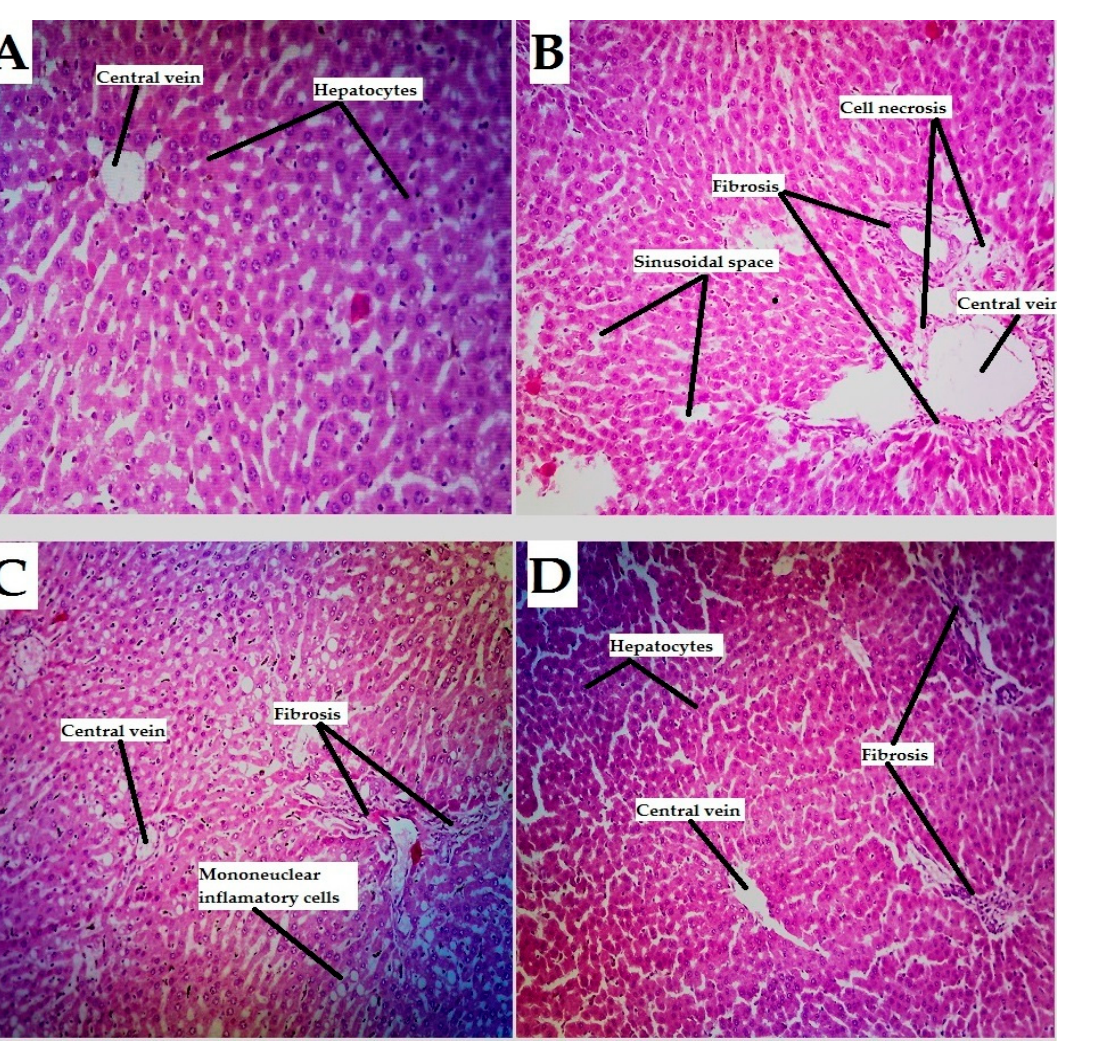
Figure 2. Histological section of rat’s liver. ( A ) The normal group showing the regular histological structure of the hepatic lobe. Note the normal central vein (CV) and normal hepatocytes. ( B ) 5-Fluorouracill-treated group showing centrilobular hepatocellular necrosis associated with hemorrhage and mononuclear inflammatory cell infiltration and fibrosis. ( C ) Group treated with 5-fluorouracill + Comp-1 (5 mg/kg I.P) showing hepatocyte degeneration, mononuclear inflam- matory cell infiltration, and fibrosis with normal central vein. ( D ) Group treated with the formula 5-fluorouracill + Comp-1 (10 mg/kg I.P) showing hepatocyte regeneration and mild fibrosis. (Fixed in a 10% buffered neutral formalin solution Stained with hematoxylin and eosin (H&E), magnification power 10 ×